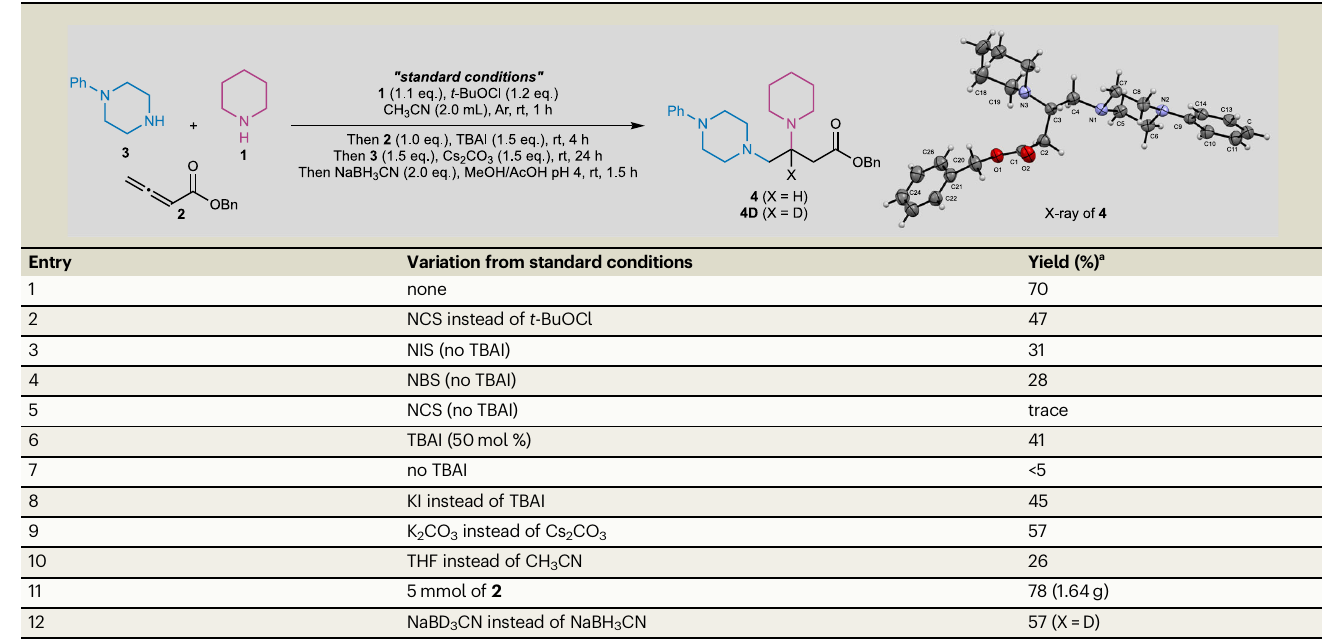
Table 1 | Optimization of the reaction